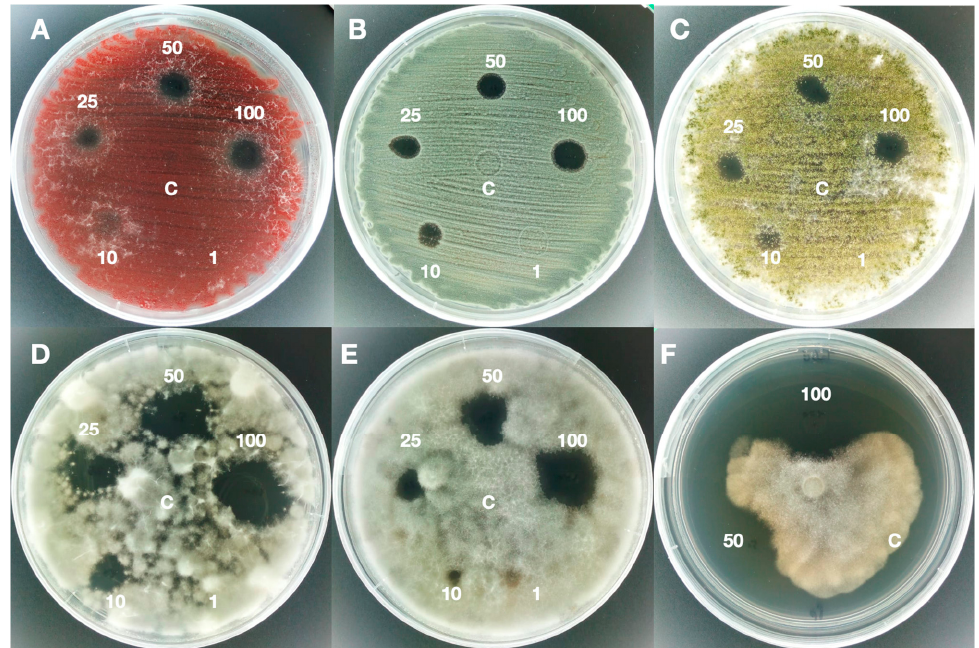
Figure 2. Agar diffusion test of Trichoderma atroviride TS extract. The picture shows the halos of antifungal activity at different concentrations (1, 10, 25, 50, and 100 mg/mL) of 30-days EtOAc extract and in comparison with the "C" control (10% DMSO) on Fusarium proliferatum ( A ), Penicillium brevicopactum ( B ), Aspergillus Flavus ( C ), Neofusicoccum batangarum ( D ), Colletotrichum gloeosporioides ( E ), and Phytophthora parvispora ( F ).